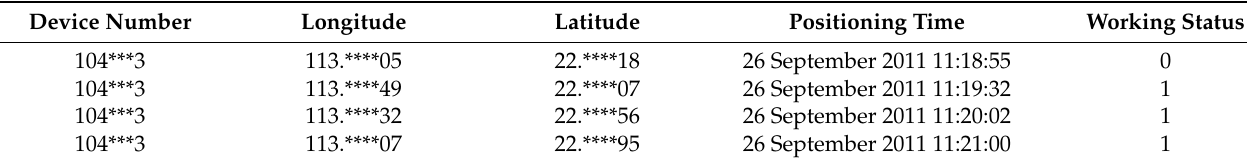
Table 1. Sample records of a GPS trajectory in Shenzhen.